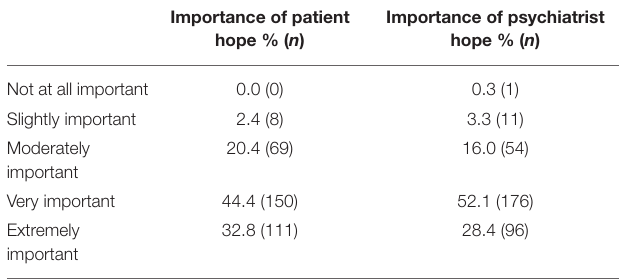
TABLE 1 | Attitudes toward patient expectations.